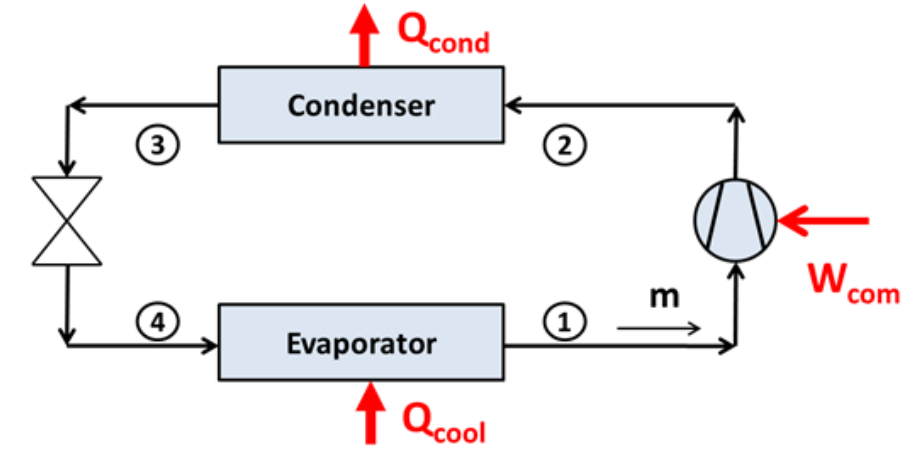
Figure A3. The basic vapor compression cycle of this Figure C1. The basic vapor compression cycle of this work.